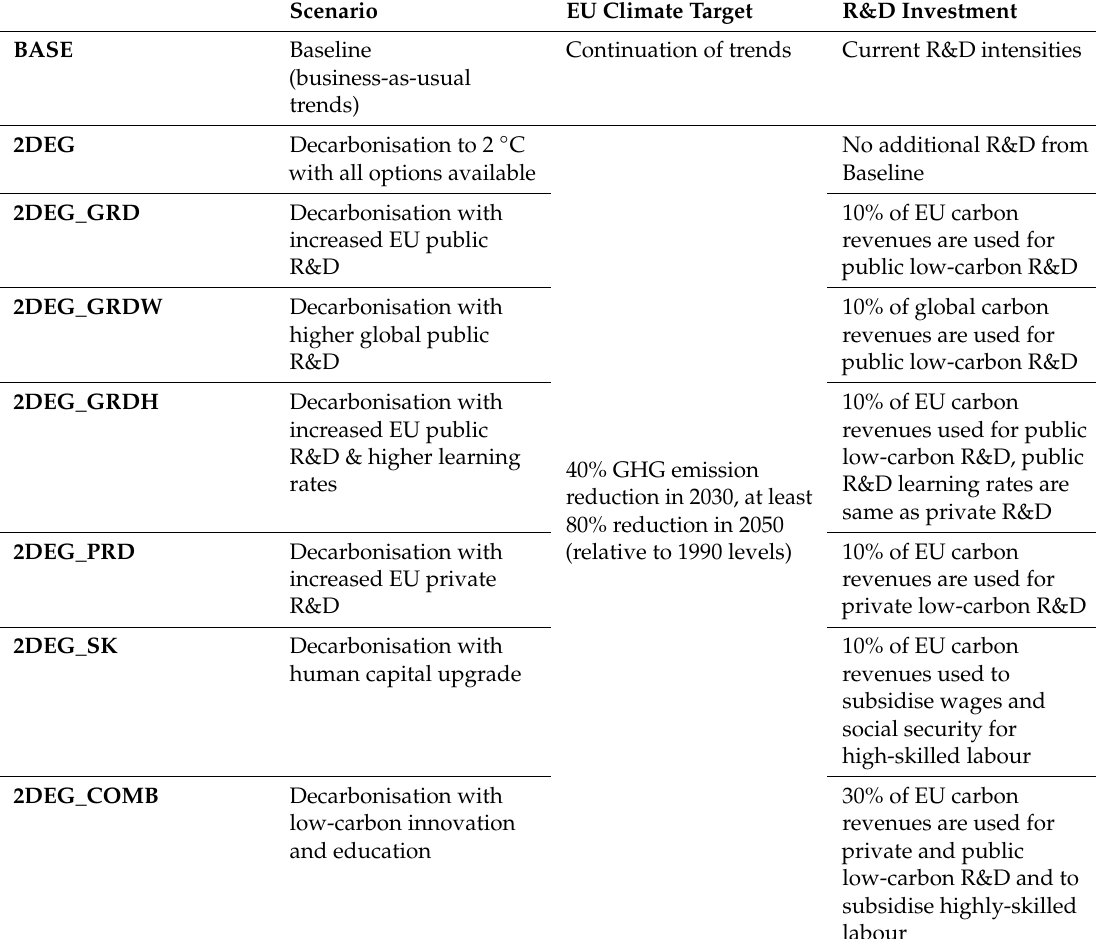
Table 2. Scenarios examined with